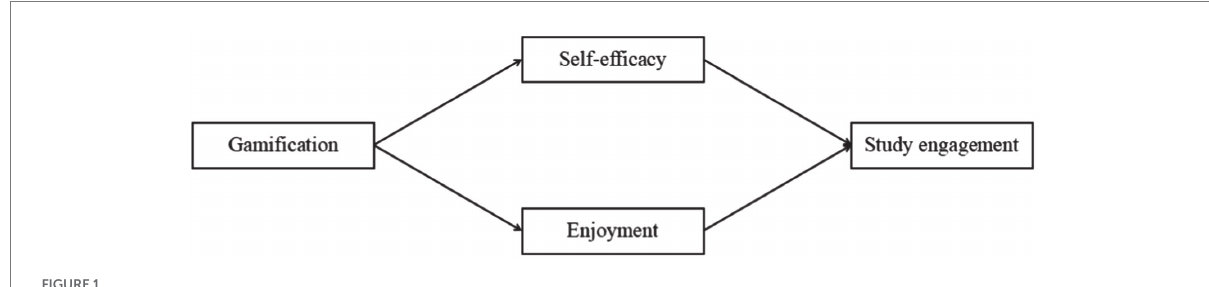
FIGURE 1 The theoretical model in this